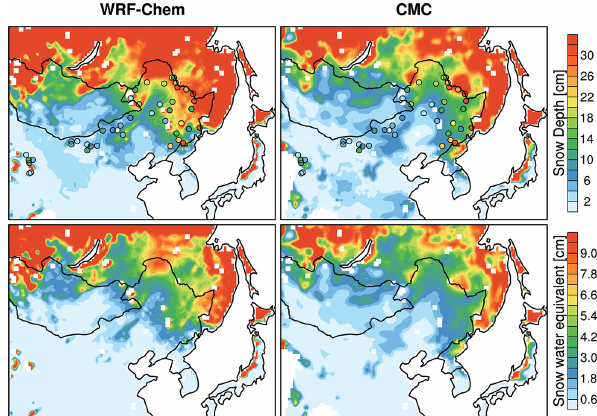
Figure 2. Spatial distribution of snow depth (cm) and snow water equivalent (cm) from the WRF-Chem simulations and CMC reanal- ysis over North China in January–February 2010. Snow depth (cm) from the campaign observations (colored circle) is also